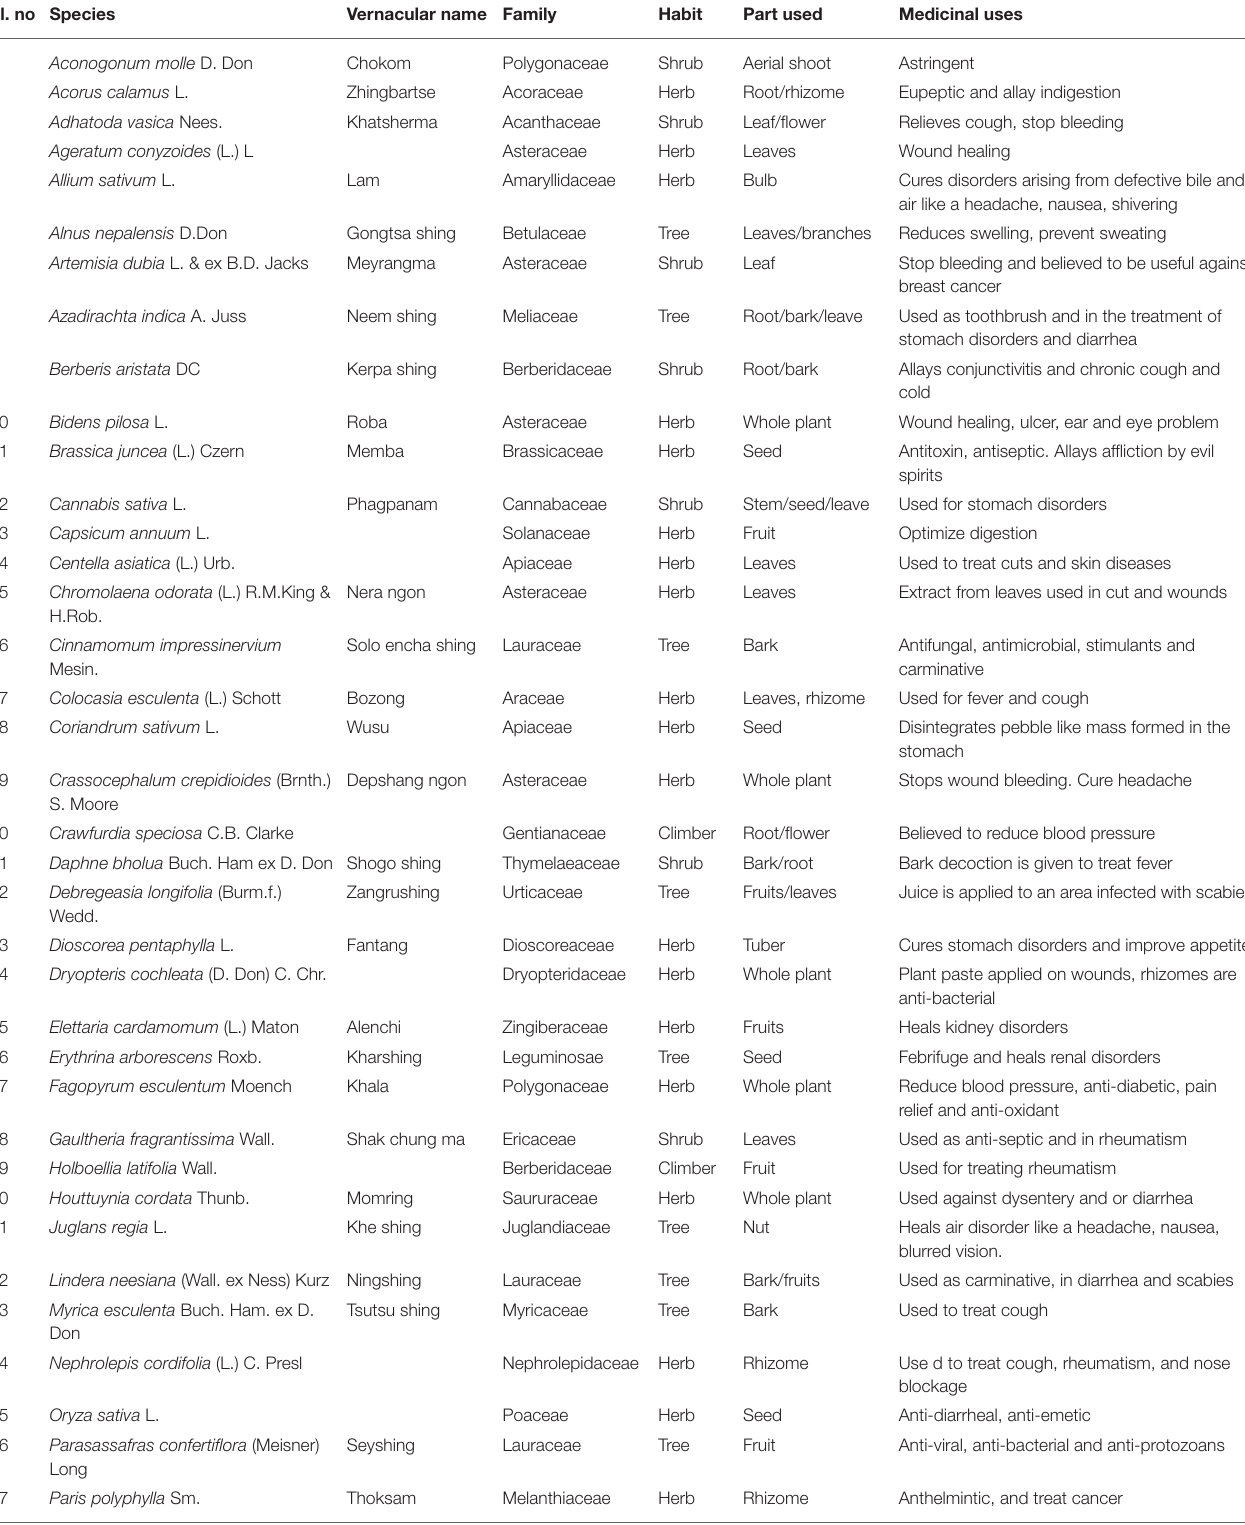
TABLE 3 | List of medicinal plant species in the broad-leaf mixed coniferous forests of Tshothang Chiwog, Lauri Gewog, Bhutan, and the ethnobotanical knowledge associated with them elucidated from the survey. Sl. no